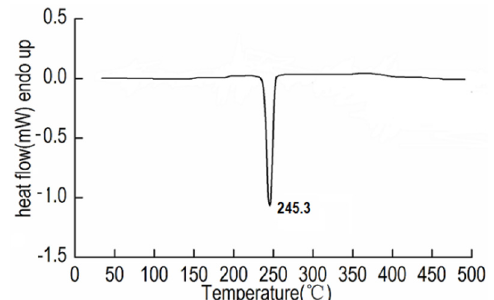
Figure 4. DSC curve of 2(SCZ) ∙ BTO at the heating rate of 5 °C ∙ min − 1 .